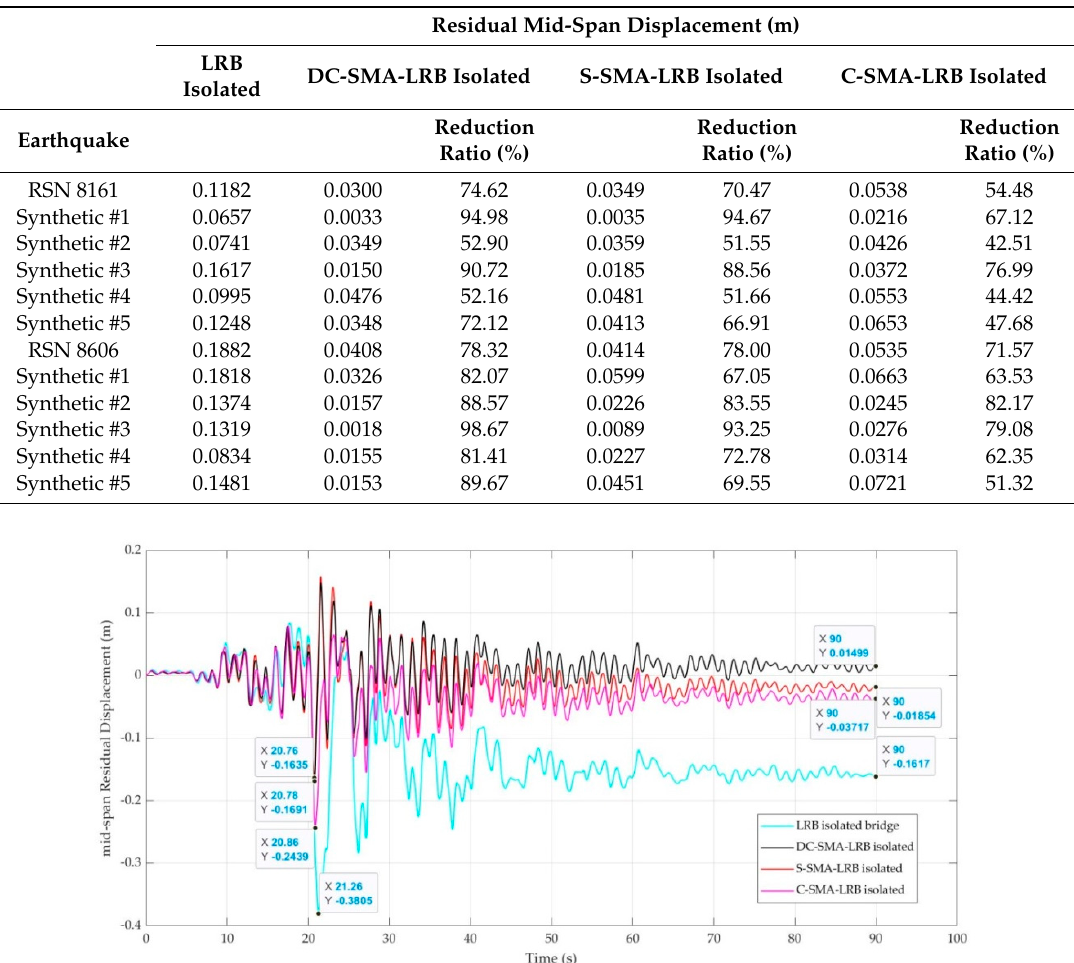
Table 7. Maximum residual displacement for the non-isolated, LRB-isolated and three SMA-LRB isolated bridges.